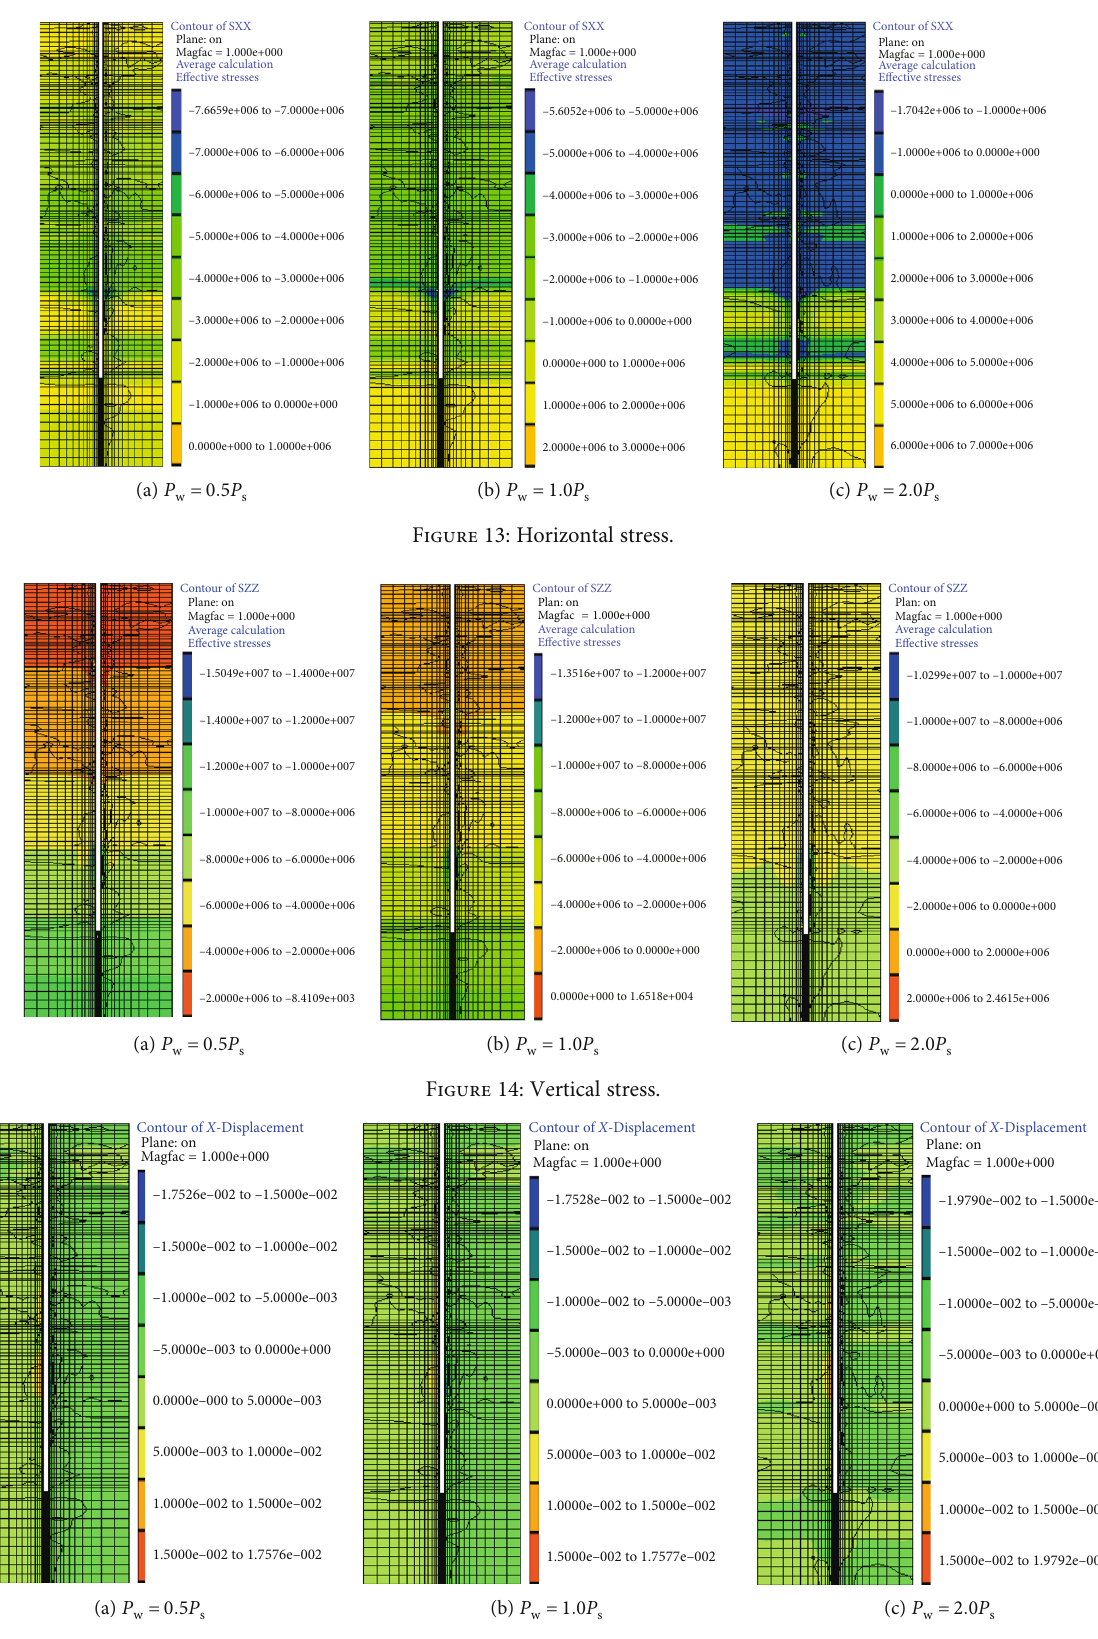
Figure 15: Horizontal displacement.